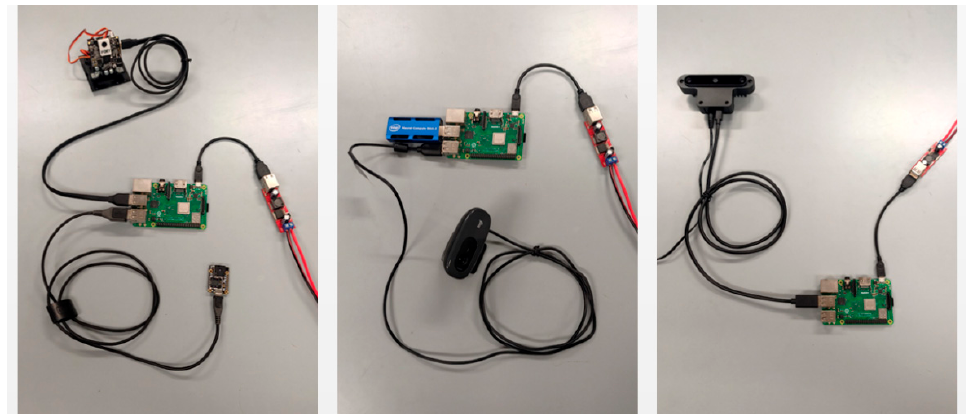
Figure 6. Typical machine vision modules: from left to right, the simple Pixy2 camera, a conventional USB camera assisted by an Intel ® NCS2 USB module, and a Luxonis OAK-D module, all installed on a hosting Raspberry Pi unit.